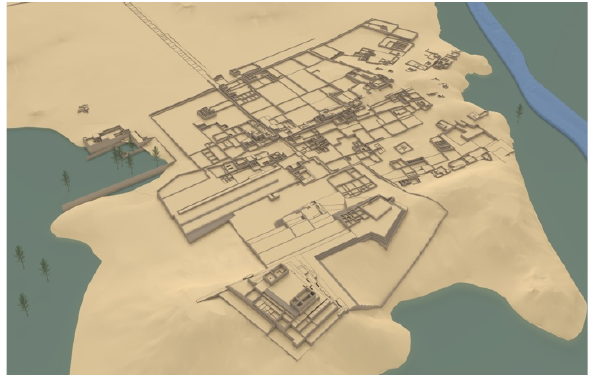
Figure 20 . Original digital model from a topographic survey by the Ychsma Project of the Université libre de Bruxelles